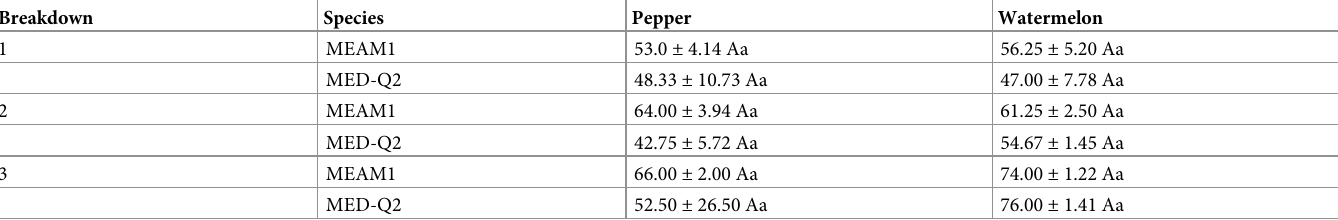
Table 2. Mean percentage of MEAM1 and MED-Q2 ± SE females from pepper and watermelon plants when inoculated with one species at 1 st , 2 nd and 3 rd break- down intervals.